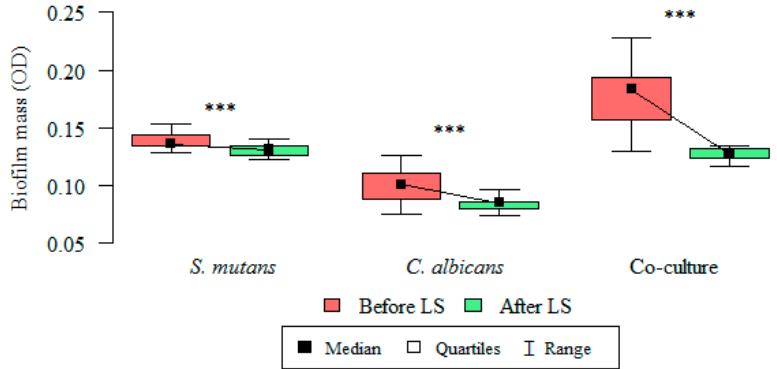
Figure 7. S. mutans , C. albicans , and oral streptococci/yeast biofilm formation: changes in optical density (OD) of biofilm mass, before and after administration of Lactobacillus salivarius (HM6 Paradens) after 24 h. Wilcoxon’s test was used for dependent (repeated) measurements (paired Wilcoxon’s test; p < 0.05). Data are represented as median ± 1–3 quartiles for three experiments. *** Indicates statistically significant difference compared to untreated biofilms ( p < 0.001).